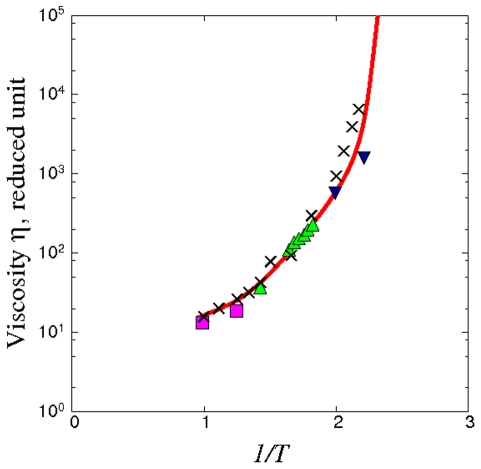
Comparison of Network model results (solid line) against Green-Kubo MD (crosses).